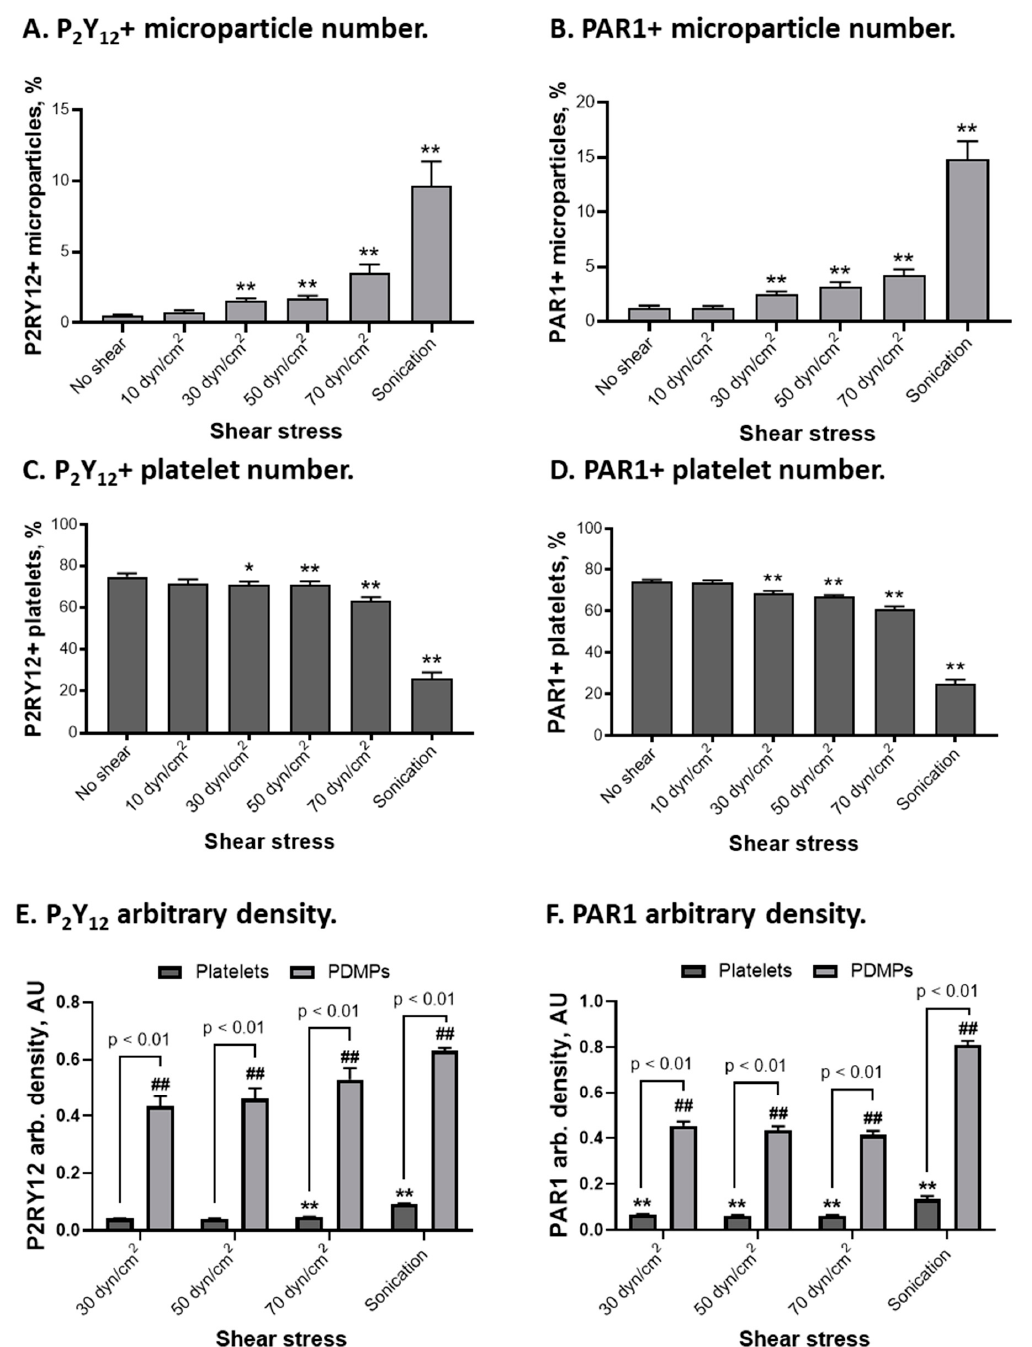
Figure 7. Distribution of P 2 Y 12 and PAR1 on platelets and platelet-derived microparticles (PDMPs): ( A , B )—number of P 2 Y 12 + platelets and PDMPs (P2RY12+/ CD41+ particles), ( C , D )—number of PAR1+ platelets and PDMPs (PAR1+/CD41+ particles), ( E , F )—arbitrary density of P 2 Y 12 and PAR1 on platelets and PDMPs. n = 4–7. Mean ± SEM, 1-way ANOVA followed by Dunnett multiple comparisons test: *— p < 0.05, **, ##— p < 0.01 vs. no shear for platelets and PDMPs.